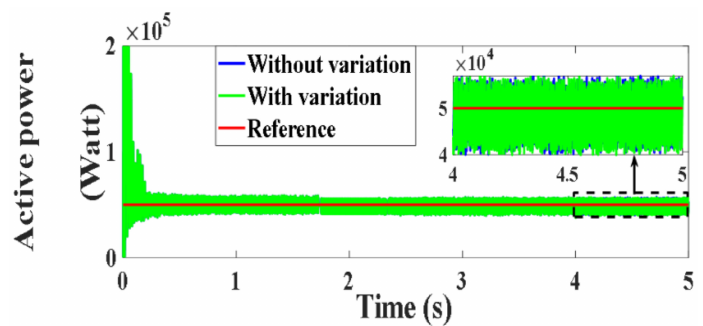
Figure 127. Active power under PVC